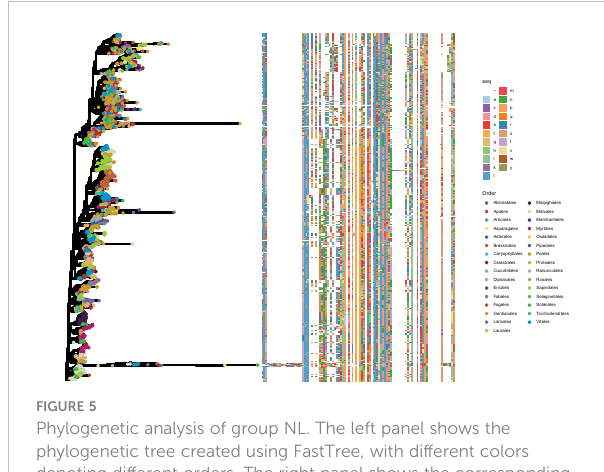
FIGURE 5 Phylogenetic analysis of group NL. The left panel shows the phylogenetic tree created using FastTree, with different colors denoting different orders. The right panel shows the corresponding aligned domain sequences, with different colors corresponding to different amino acids.